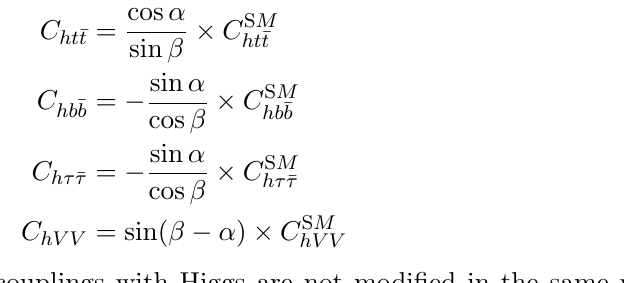
) (right) in Type I H (cid:6)